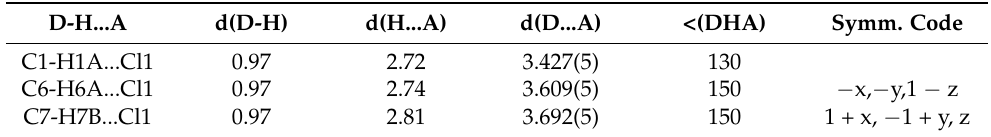
Table 3. Hydrogen bond parameters (Å, ◦ ) in the [Cu 3 (L a ) 4 (Cl) 6 ]